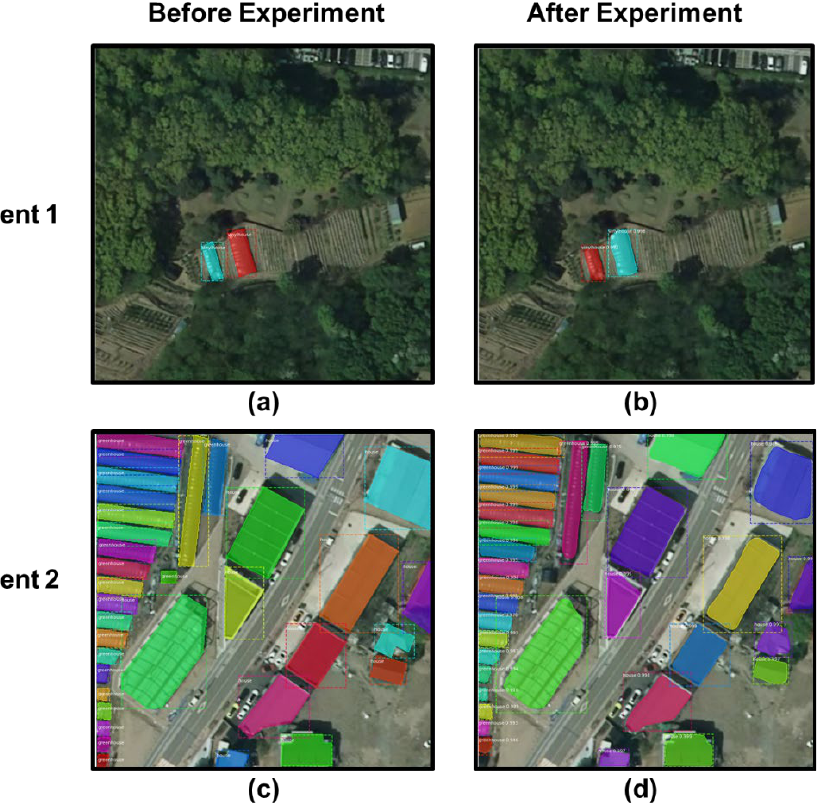
Figure 3. The model results before and after the experiment. ( a ) Annotations in original image before experiment 1. ( b ) Mask and bounding box of detected objects after applying the Cascade Mask R-CNN model for Experiment 1. ( c ) Annotations in the original image before experiment 2. ( d ) Mask and bounding box of detected objects after applying the Cascade Mask R-CNN model for Experiment 2.